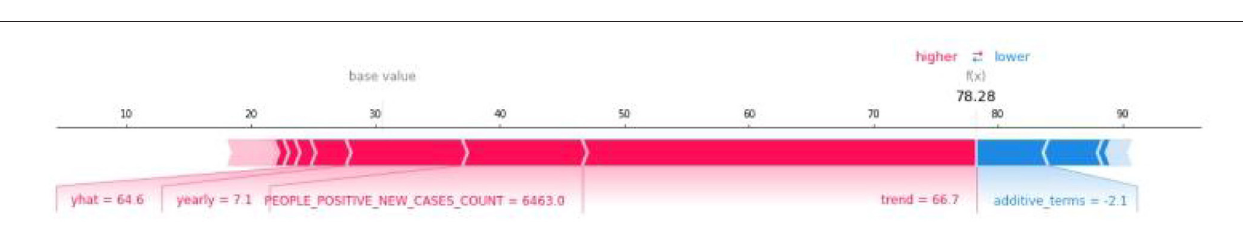
FIGURE 5 | The SHAP force plots for a number of the OPHS prediction. The number of psychological help-seeking (PHS) rated in this example shows a prediction of 78.28 on the rating scale. In particular, the positive new case count of the people, equal to 6,463, increases its